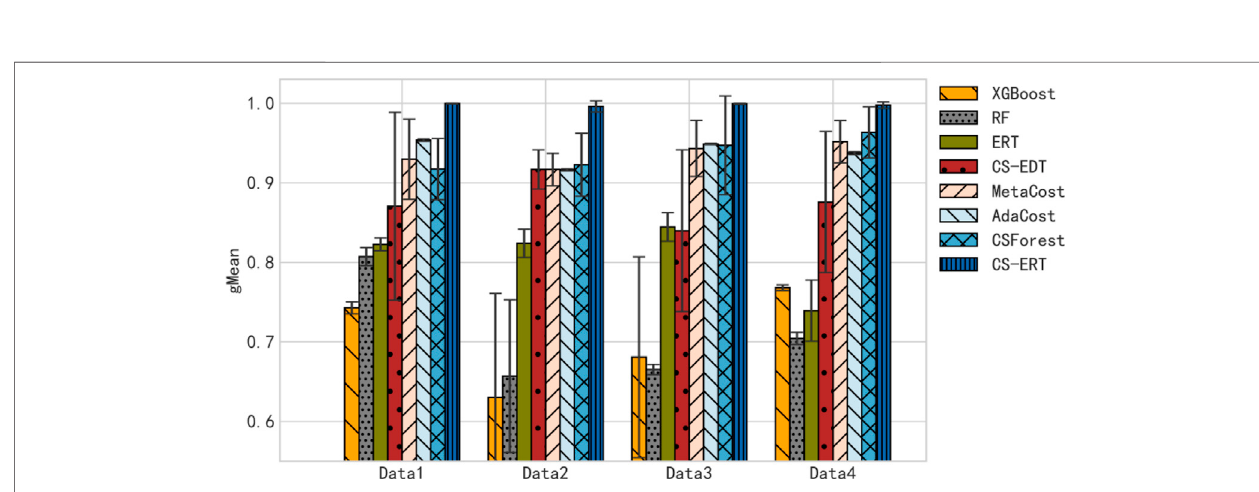
Frontiers in Energy Research |